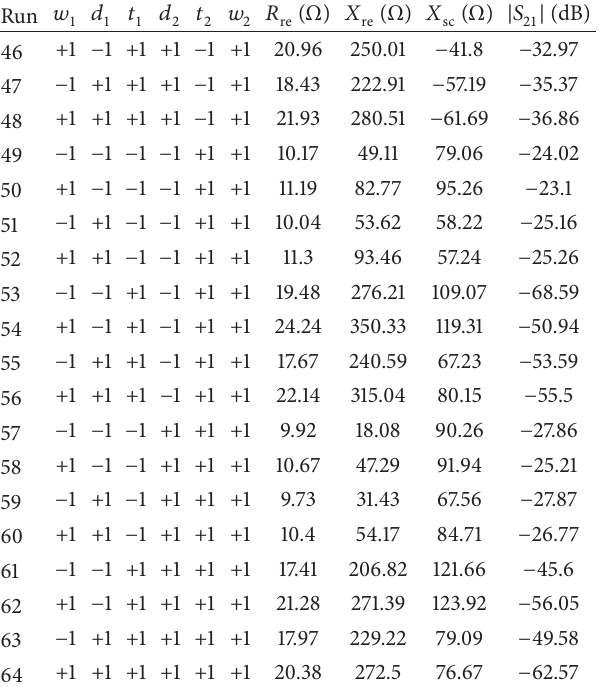
Table 5: The 2 6 full factorial design and the simulated results (at 915